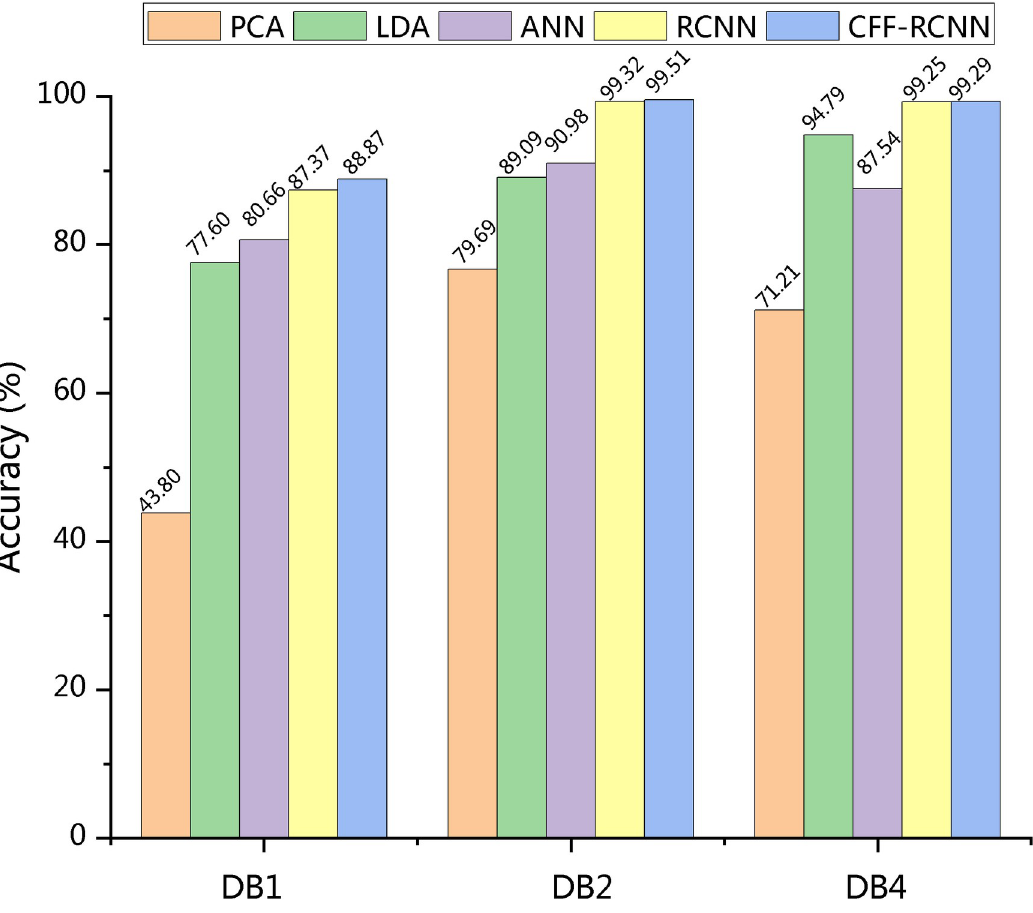
Fig 5. Classification accuracy of the proposed